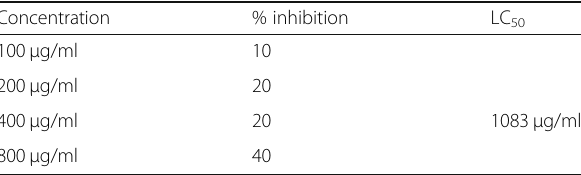
Table 6 Cytotoxic effect of EMSL on Brine shrimp lethality